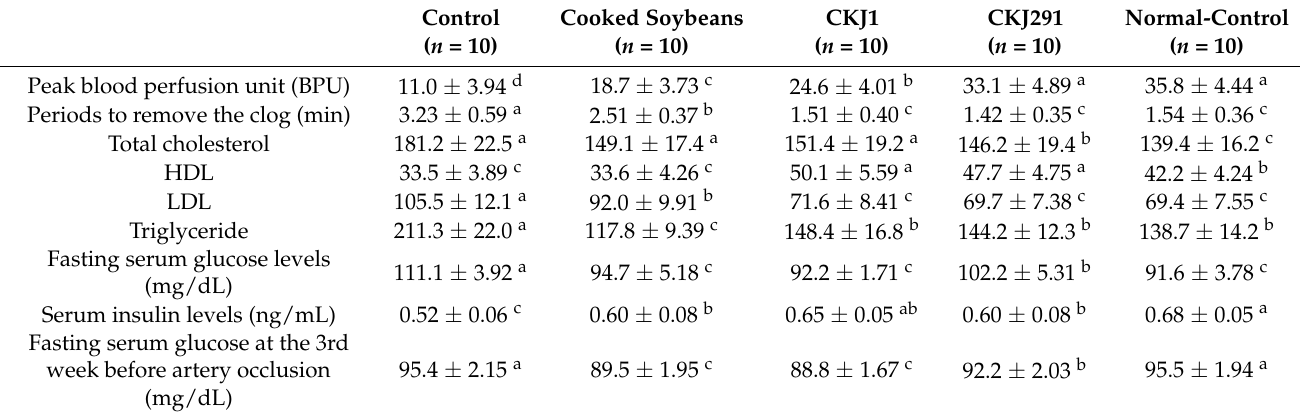
Table 4. Blood flow and lipid profiles on the 3rd week after artery occlusion. Control Cooked Soybeans ( n = 10) ( n = 10)